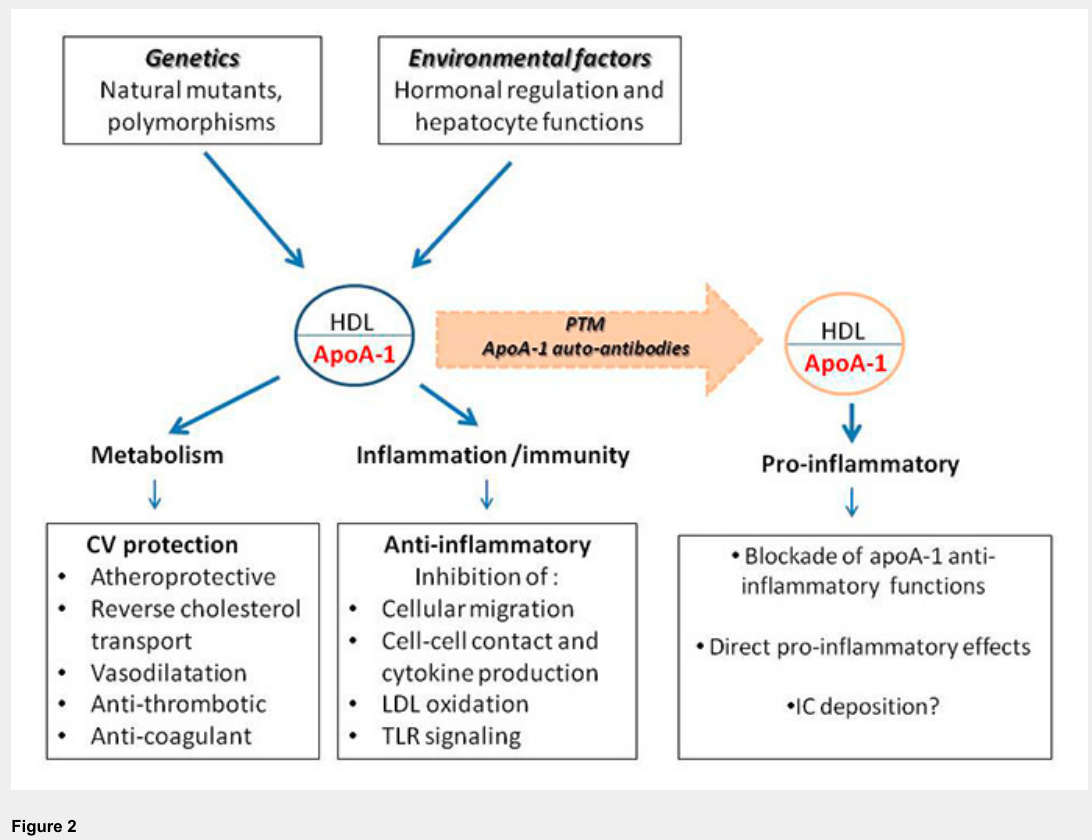
Figure 2 The pro- and anti-inflammatory role of apolipoprotein A-1 (apoA-1) / high-density lipoprotein (LDL). CV = cardiovascular; IC = immune complexes; LDL = low-density lipoprotein; PTM = post-translational modifications; TLR = Toll-like